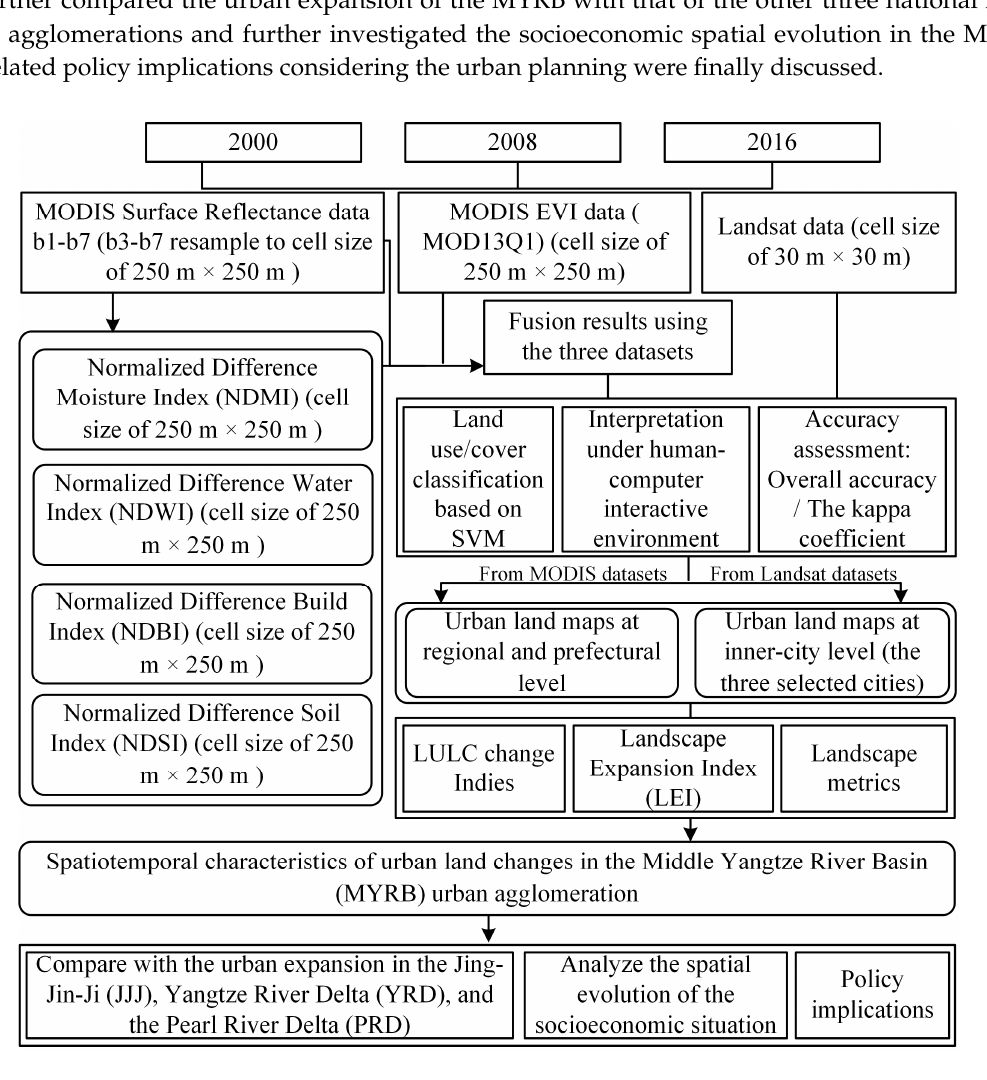
Figure 2. Framework of data processing and analysis.